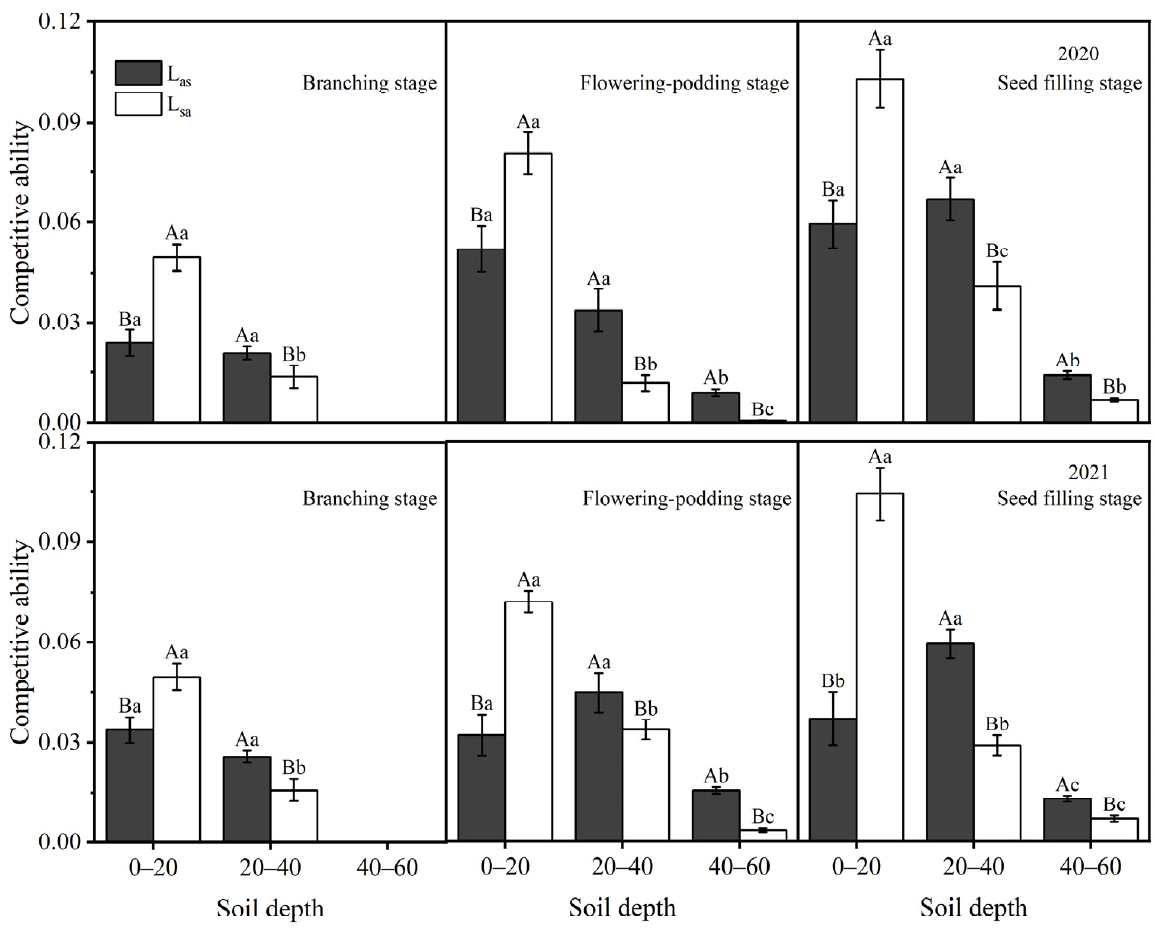
Figure 6. Competitiveness index of apple–soybean agroforestry system in the vertical direction. L as : competitiveness index of apple to soybean; L sa : competitiveness index of soybean to apple. Lowercase letters indicate the significance analysis of different soil depths of the same species ( p < 0.05). Capital letters indicate the significance analysis of the same soil depth for different species ( p < 0.05).